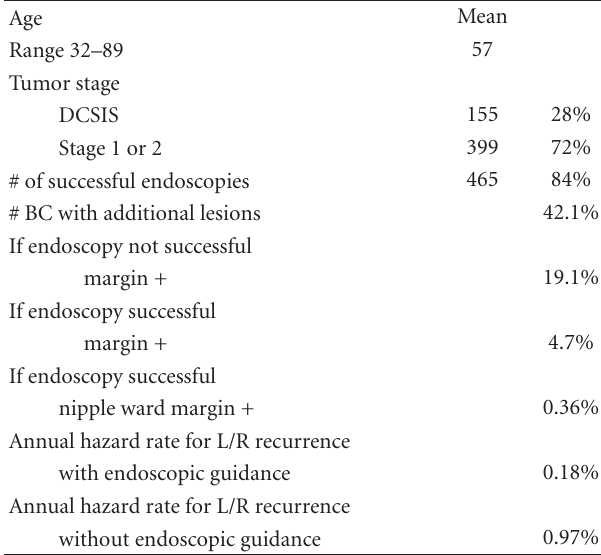
Table 1: Case distribution and